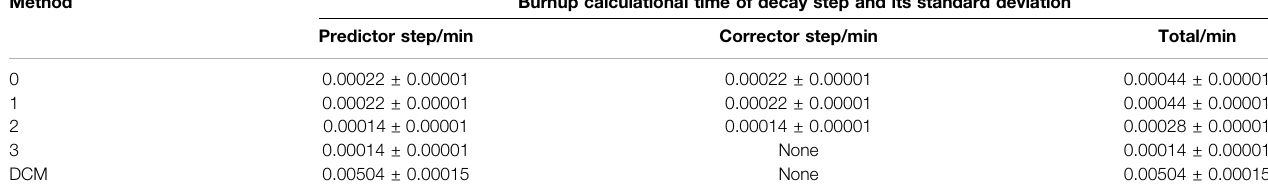
TABLE 6 | Decay step calculational times using the various methods.